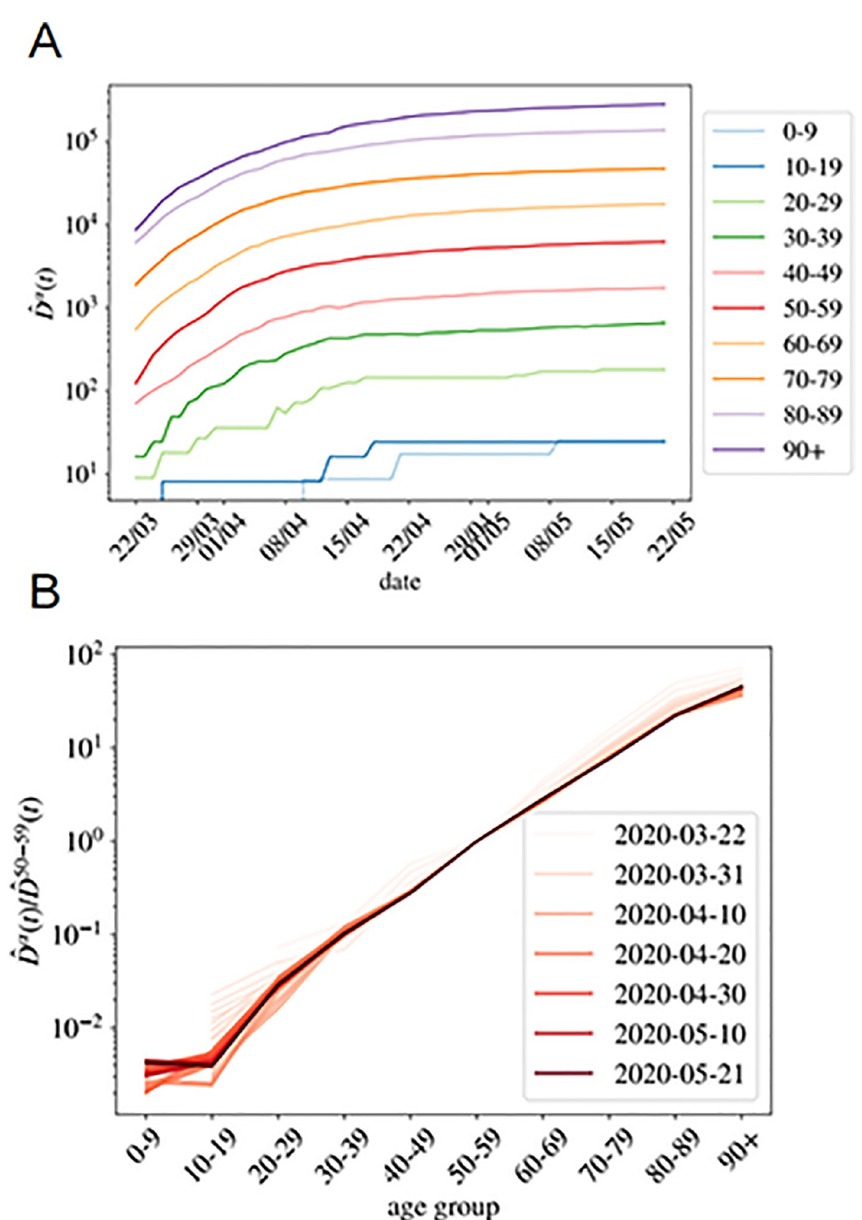
Fig 1. Normalized number of deaths occurred in French hospitals as a function of age. A We show the evolution with time of the cumulative number of deaths normalized by the number density of individuals in age group α (i.e. ^ D ð t Þ in Eq (2)). In B , we show ^ D ð t Þ = ^ D ð t Þ as function of the age group, for all the times in A (the darker the a a 50 (cid:0) 59 color, the more recent the measurement, and we give some dates in the legend). This quotient is essentially time- independent as discussed in Eq (7), and it lets us estimate the quotient between the UIFR (the IFR under the = ^ f . assumption of uniform attack rate, see Eq (6)) of the two age groups, that is, ^ f a 50 (cid:0) 59